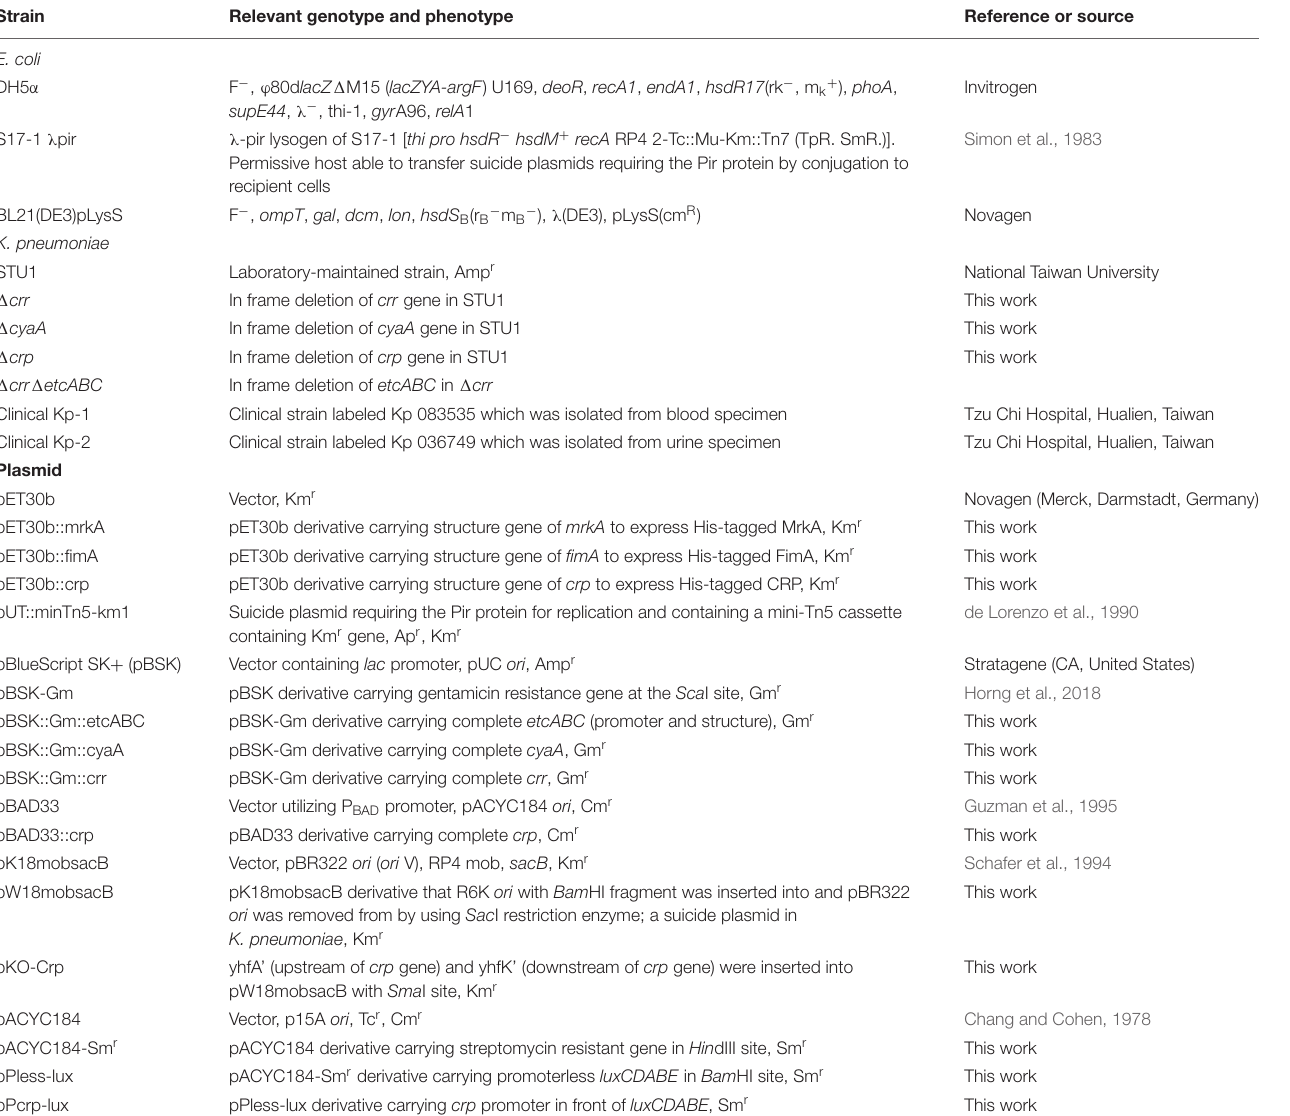
TABLE 1 | Bacterial strains and plasmids used in this